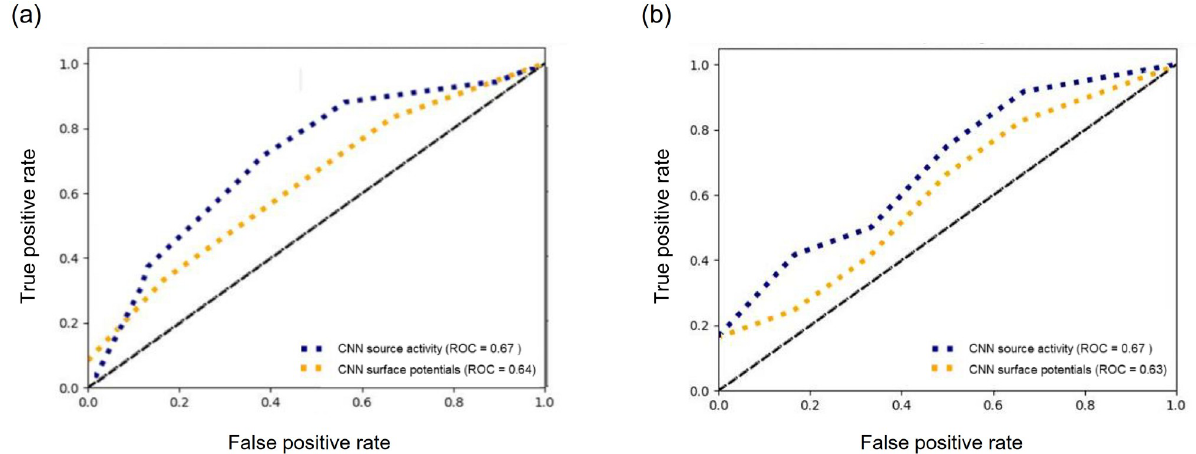
Fig 8. ROC AUCs (receiver operating characteristic area under curves for (a) pre-stimulus and (b) on-going stimulus segments. ROC curve was calculated when using source activity and surface potentials, for each case we use the frequency band that produce higher results.